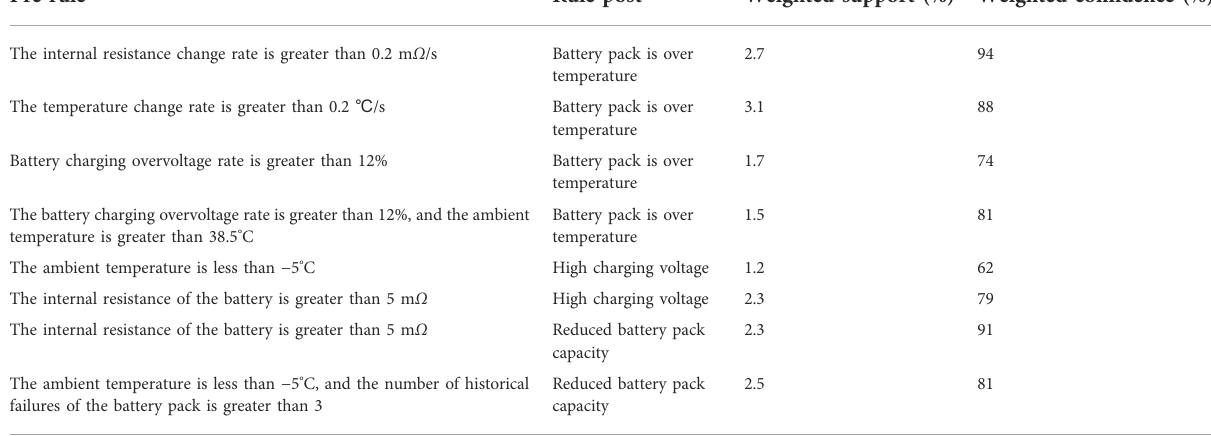
TABLE 6 Power battery failure association